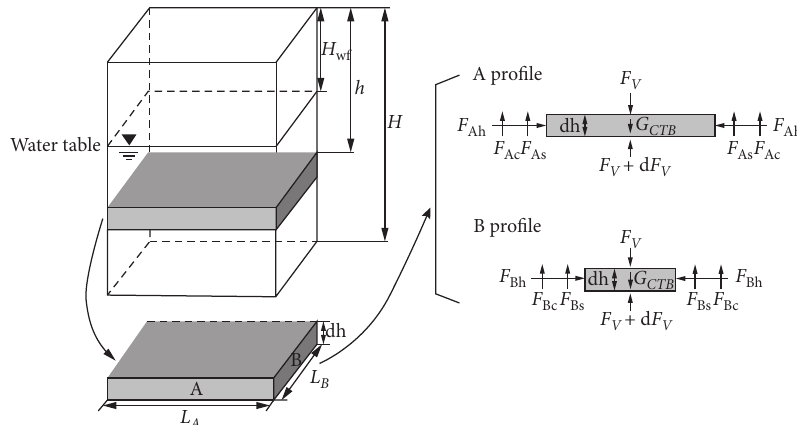
Figure 2: Force analysis in the unsaturated zone of CPB mass ( H wt : local water table location, h : thickness of CPB relative to top surface, H : filling height, L A : longitudinal length of CPB mass, L B : transverse length of CPB mass, d h : thickness of the representative CPB layer, F h : horizontal force, F v : vertical force, F c : interface adhesion, F s : interface friction force, and G CPB : self-weight load of